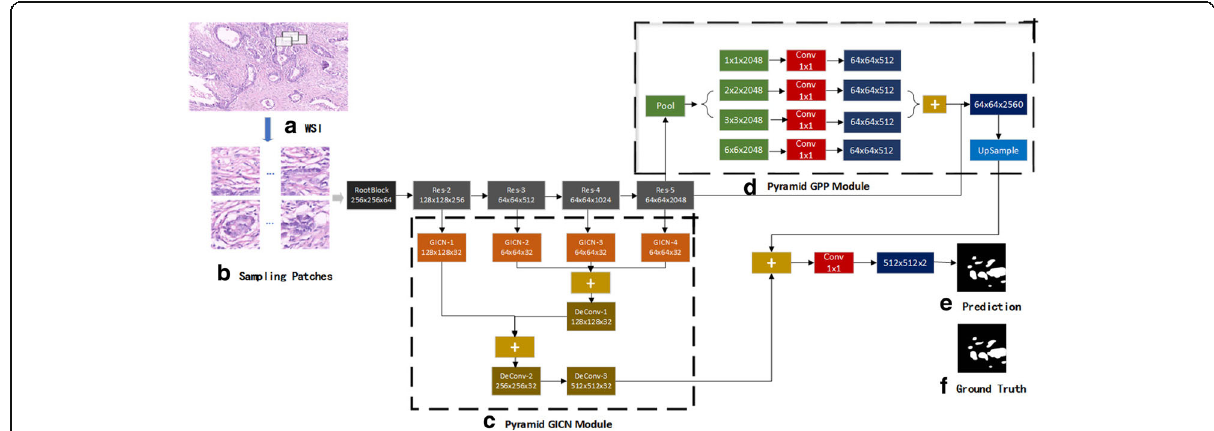
Fig. 1 The semantic segmentation network structure. a Digital histopathology images. b Sampling data for patch sampling (size 512 × 512). c Multi-level feature pyramid to extract spatial information. d Multiscale features pyramids focus on smaller targets. e Segmentation results, based on pixel-level prediction. f Ground